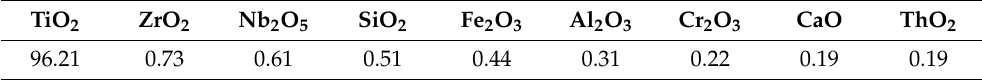
Table 1. Analysis results for the chemical composition of rutile/%.